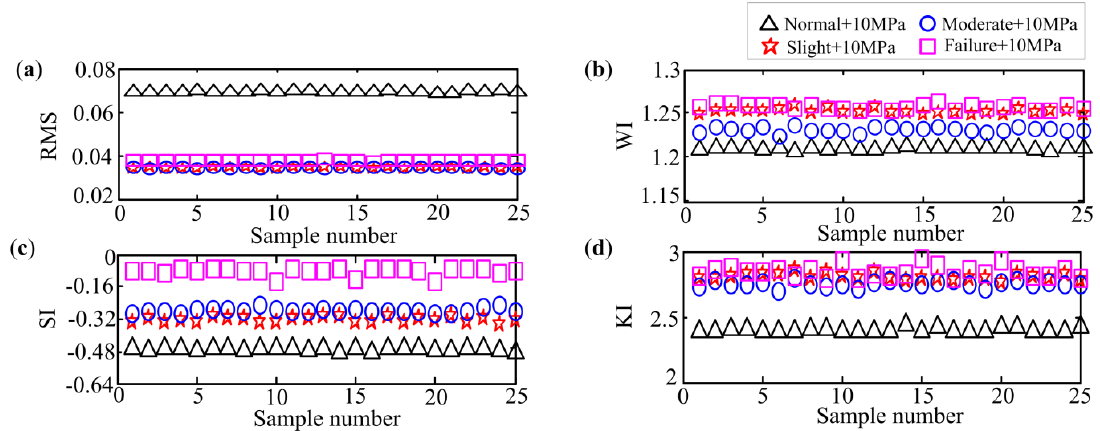
Figure 12. The commonly used time-domain degradation indices. ( a ) Root mean square (RMS); ( b ) waveform index (WI); ( c ) skewness index (SI); ( d ) kurtosis index (KI).